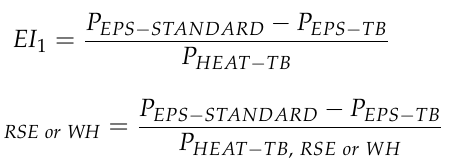
Figure 12. Dependence of heat costs for the thermal barrier (€/(year ∙ m 2 )).